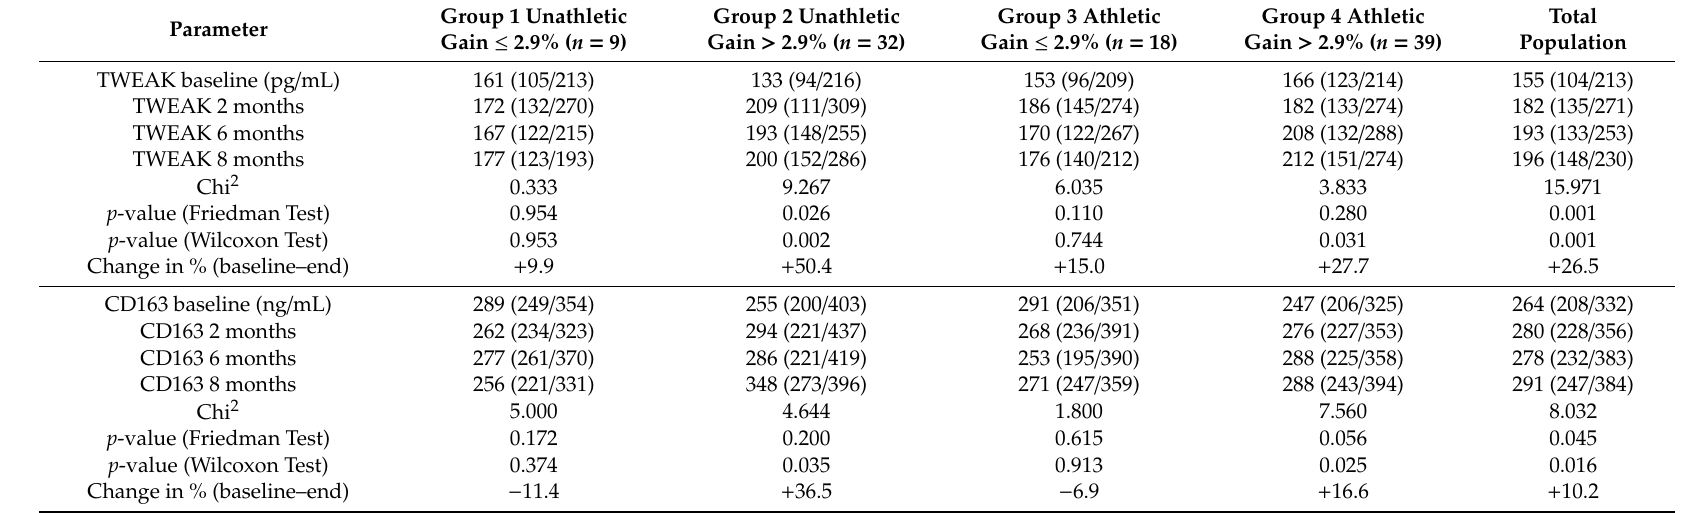
Table 3. sTWEAK and sCD163 levels over the observation time: data of the biomarkers are shown at baseline and after two, six and eight months of training and their change from baseline to the end of the observation period in %. Furthermore, the results of the Friedman test and Wilcoxon signed rank test are shown. Data of the biomarkers are given as median (25th / 75th